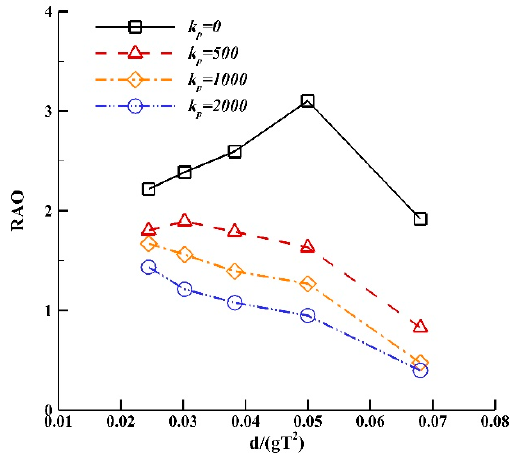
Figure 20. Effects of PTO coefficient on hydrodynamic performance of the buoy ( H = 0.1 m). Figure 20. E ff ects of PTO coe ffi cient on hydrodynamic performance of the buoy ( H = 0.1